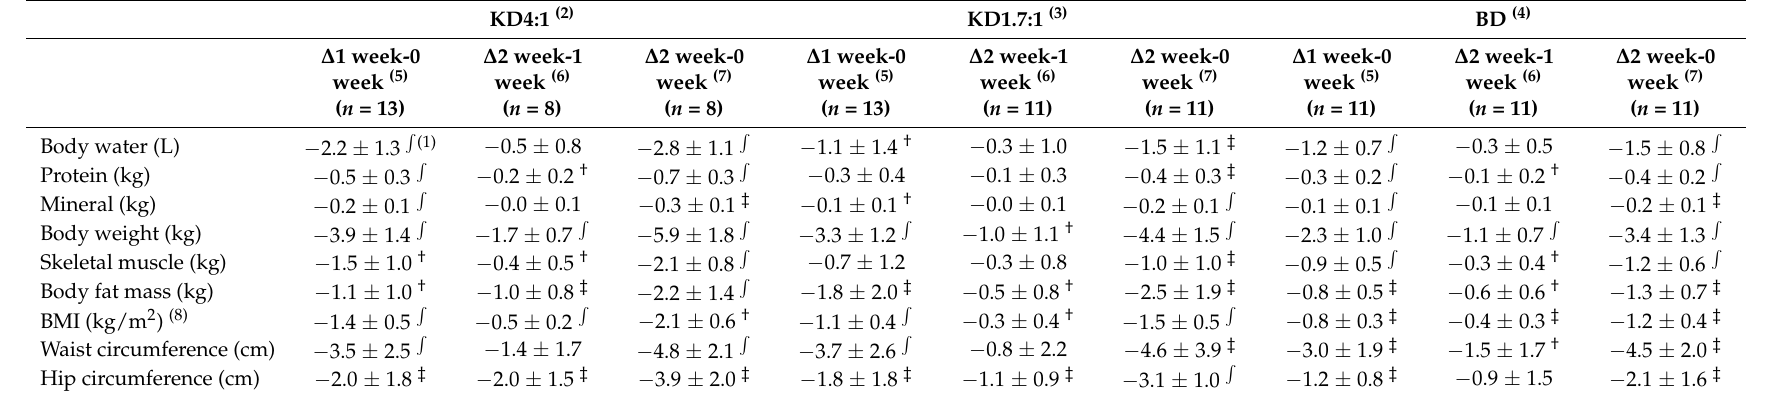
Table 4. Changes in anthropometry and body composition by each